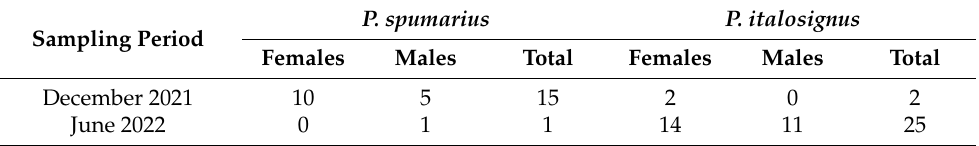
Table 4. Summary of field experiment samplings regarding Philaenus spp. For every specimen, the results of our qPCR assay were never conflicting with our preliminary morphological analysis. P. spumarius P. italosignus Sampling Period Females Males Total Females Males Total December